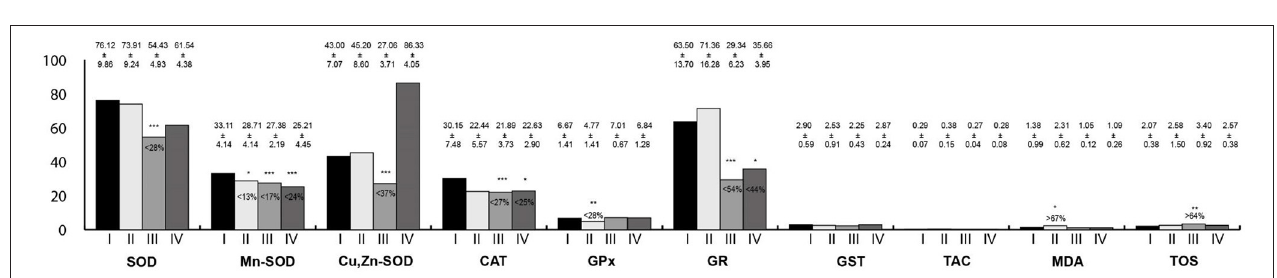
FIGURE 5 | Oxidative stress parameters in the small intestine homogenates. I, control group; II, group exposed to LF-EMFs; III, group exposed to RF-RMF; IV, group exposed simultaneously to LF-EMFs and RF-EMFs; SOD, superoxide dismutase (NU/mg protein); Mn-SOD, manganese-dependent superoxide dismutase (NU/mg protein); Cu,Zn-SOD, copper- and zinc-dependent superoxide dismutase (NU/mg protein); CAT, catalase (IU/g protein); GPx, glutathione peroxidase (IU/g protein); GR, glutathione reductase (IU/g protein); GST, glutathione S-transferase (IU/g protein); TAC, total antioxidant capacity (mmol/g protein); MDA, malondialdehyde ( µ mol/g protein); TOS, total oxidative status. Differences statistically important at * p < 0.05; ** p < 0.01; *** p < 0.001; p -value: particular study group vs. control group; p -value was added only if statistically significant. Percent values mean difference between study and control group; they were given if p -values were significant.